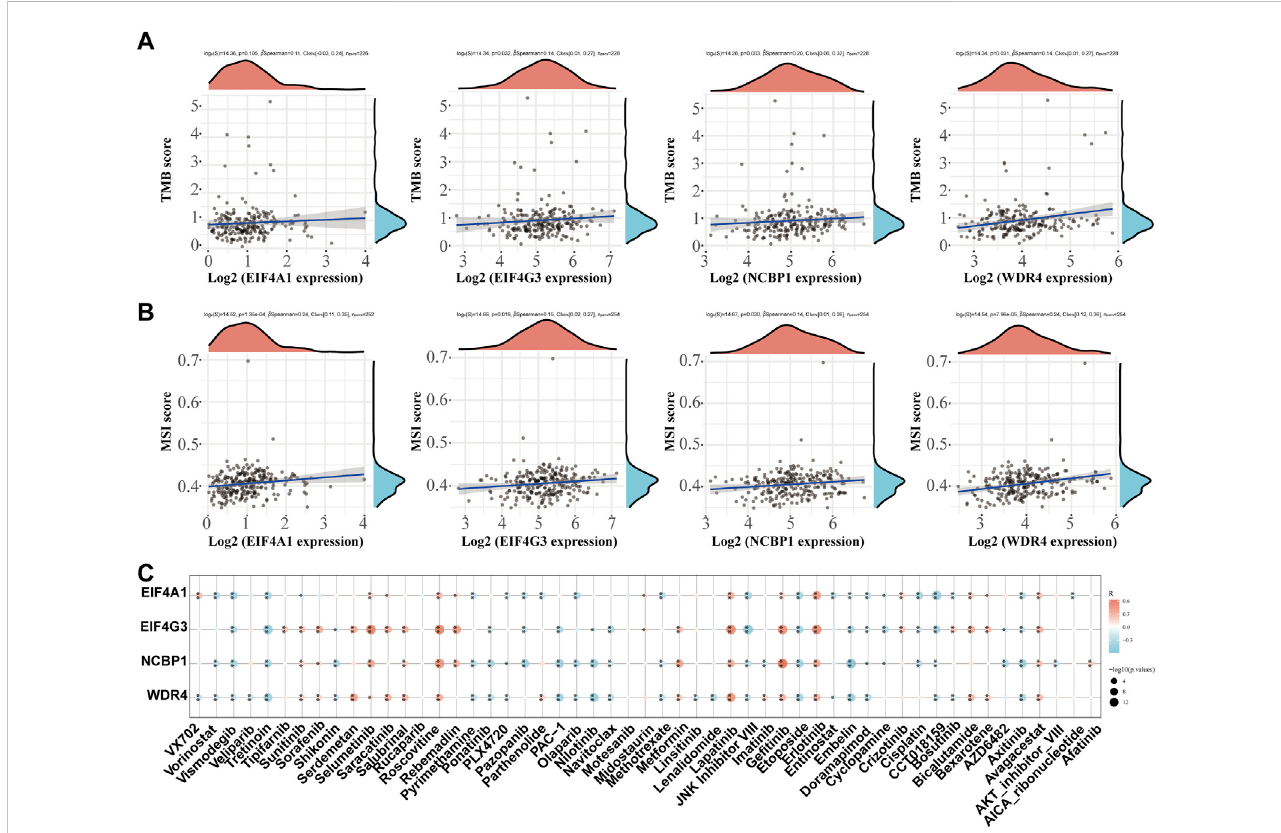
FIGURE 10 TMB, MSI and drug sensitivity. (A) Correlation between the expression of prognostic m7GRGs and TMB in sarcomas; (B) Correlation between prognostic m7GRGs and TMB in sarcomas; (C) Correlation between prognostic m7GRGs and antitumor drugs in